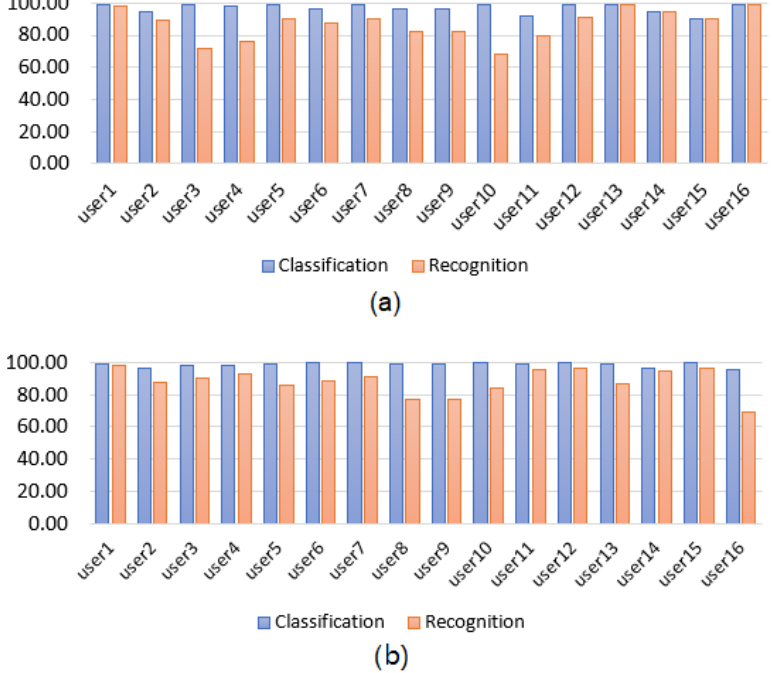
Figure 4. User-specific HGR model classification and recognition accuracy results for the Myo armband sensor using DQN. ( a ) Static gestures. ( b ) Dynamic